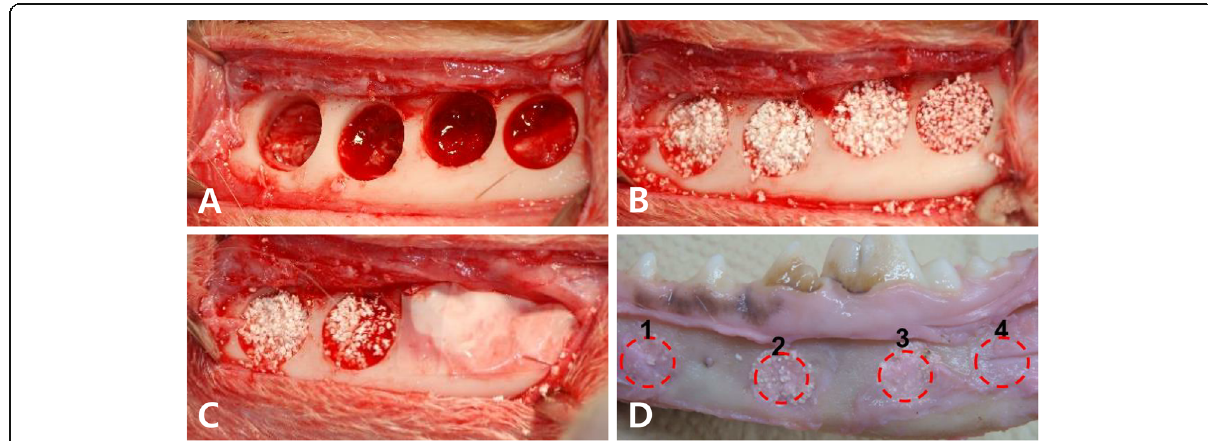
Fig. 1 Experimental photograph. a Drilling holes of 8.0 mm were made on mandible of dog. b The defects were filled with OSTEON II (Genoss Co., Suwon, Korea). c Two of four holes were covered with Osteoguide membrane (Genoss Co., Suwon, Korea). d Sacrifice was performed at 4 and 8 weeks after